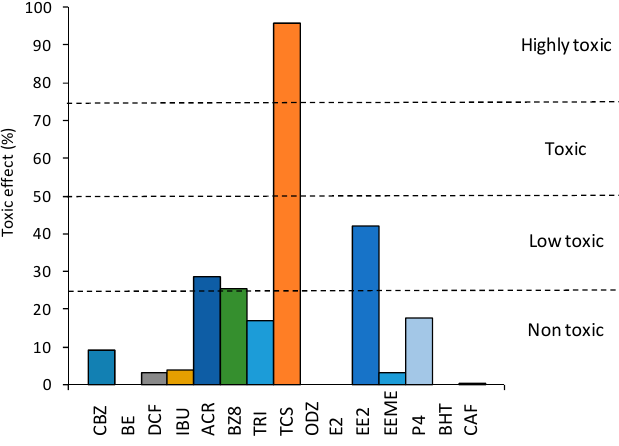
Figure 4. Toxicity of micropollutant water solutions.